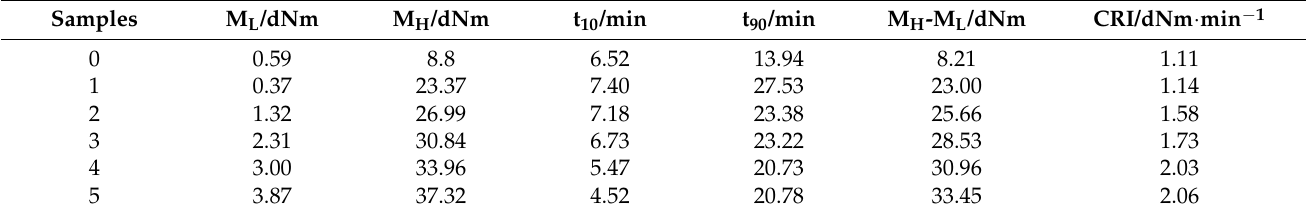
Table 2. Cure characteristics of unfilled and filled